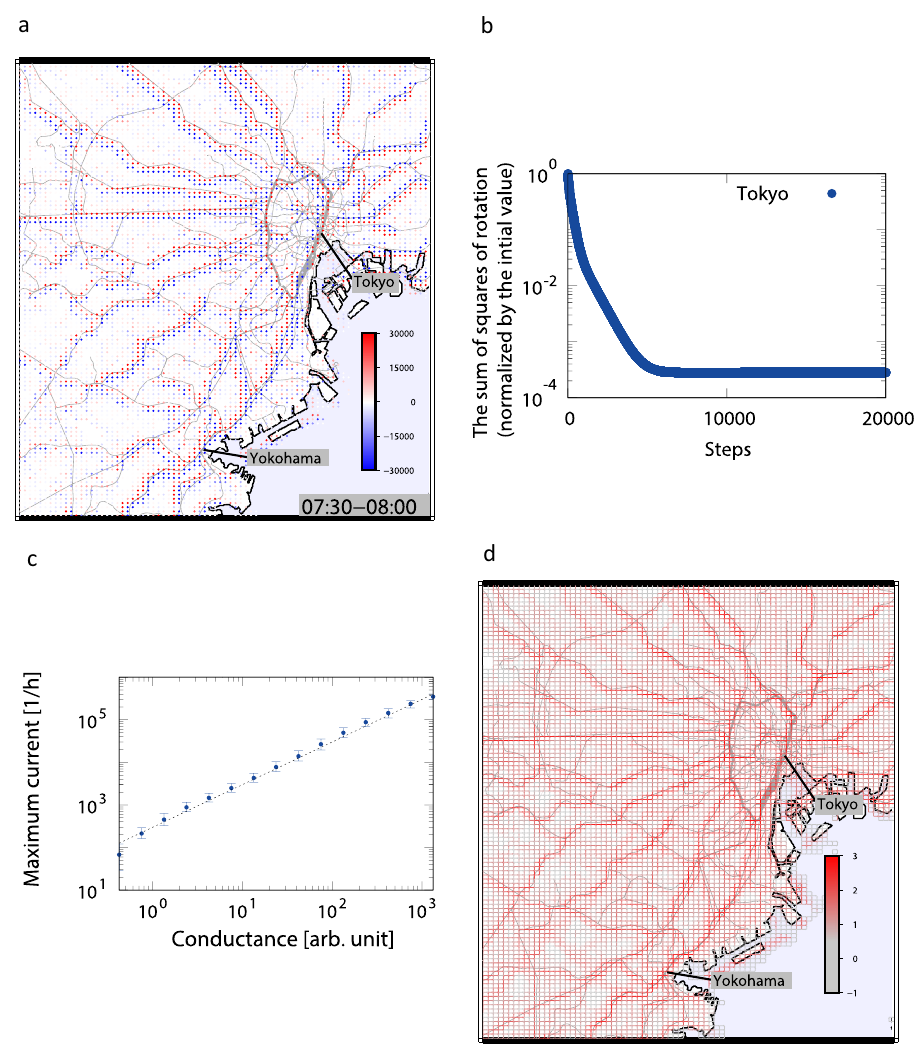
Figure 2. Optimization process and estimated conductance around Tokyo metropolitan area. ( a ) Rotation patterns on the map in the morning. ( b ) Step-by-step decrease in the sum of squares of rotation calculated in the Tokyo metropolitan area. ( c ) Relationship between the maximum current at each cell for a day and the estimated conductance with a scaling exponent of 1.0. ( d ) Volume map of conductance in the Tokyo metropolitan area drawn on a logarithmic